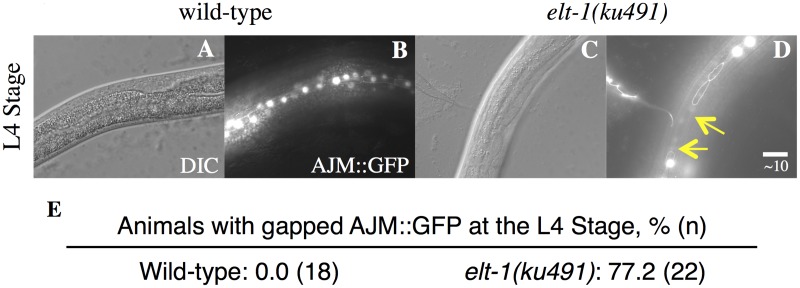

elt-1/(ku491) mutant animals have defective adult alae formation.A-D, DIC and GFP fluorescence images showing adherins junctions of L4 animals with indicated genotypes. Arrow in D marks the gap of AJM::GFP fluorescence. E, Percentage of L4 animals with AJM::GFP fluorescence gaps in animals with the indicated genotypes.